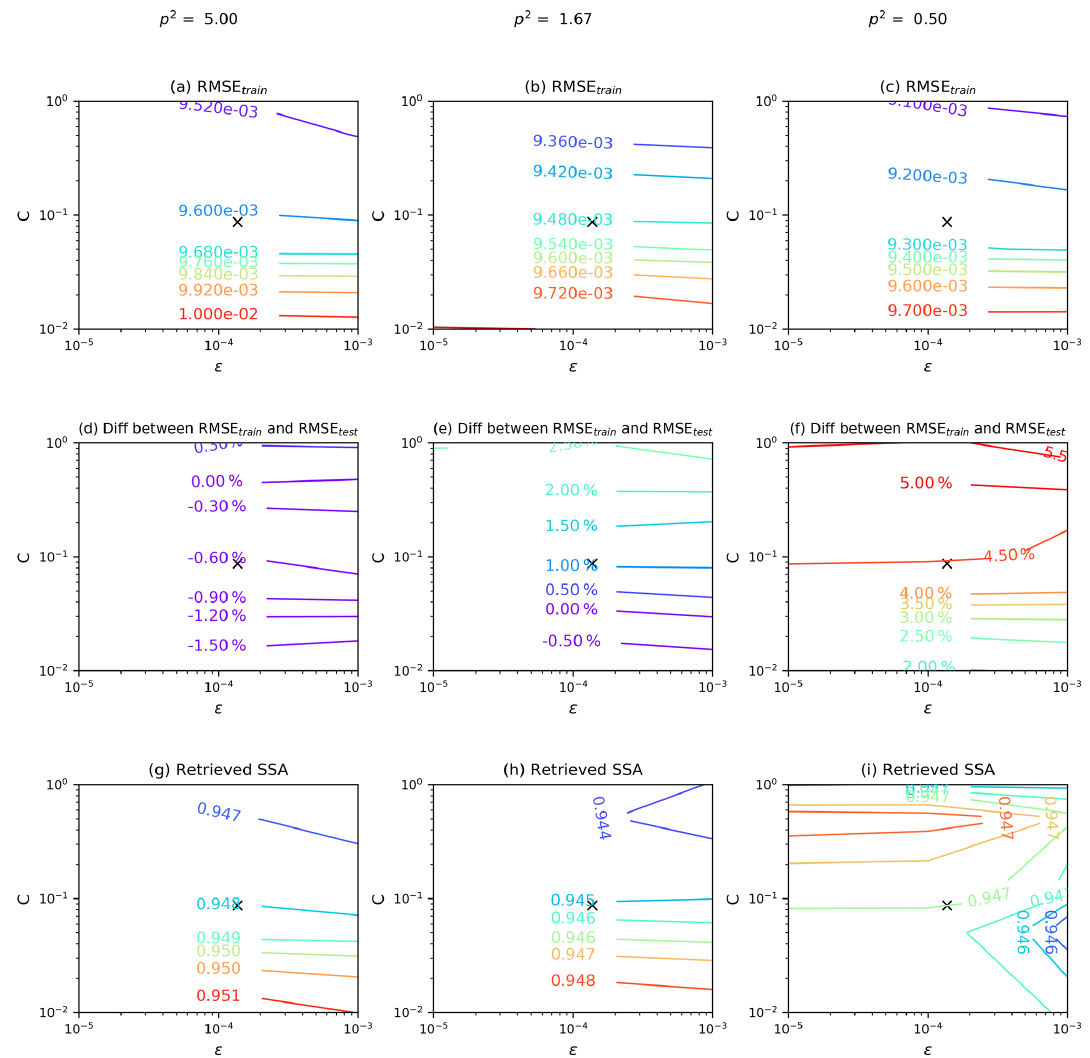
Figure 7. The performance of the SVR model as a function of hyper-parameters (C, ε and p ). The cross markers represent the values of C and ε according to Cherkassky and Ma (2004). A p 2 value equal to 1.67 is sufficient to obtain a relatively high accuracy and also prevents overfitting of the training data